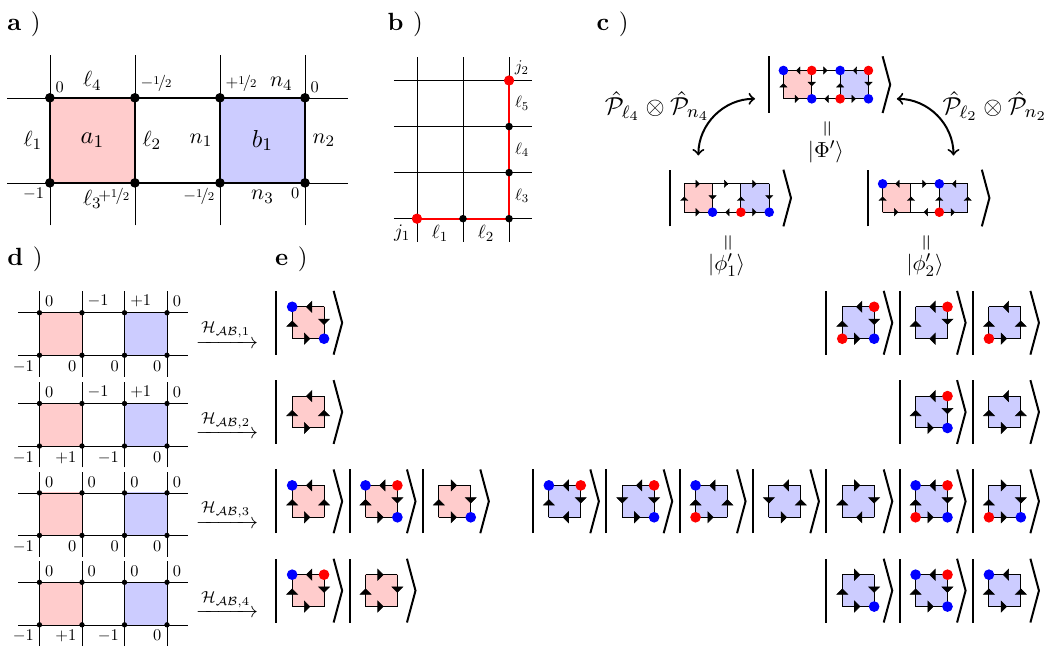
Figure 3. (a) Geometry for L , SS, and sub-regions A and B chosen in the example calculations in presence of dynamical fermions. (b) Example of a path, Γ = [ ‘ 1 , . . . , ‘ 5 ] , connecting two lattice points j 1 and j 2 . Dynamical fermionic matter lives on the lattice sites, while gauge fields live on links between sites. (c) A linear combination of the three states depicted yields an entangled state of a U(1) gauge theory in presence of dynamical fermionic matter. The entanglement can be witnessed by the operator ˆ C 0 defined in equation (4.4). Its constituents are path operators ˆ P ‘ ⊗ ˆ P n and 4 4 ˆ P ˆ P ‘ 2 ⊗ n 2 (see equation (4.2)), which connect the three states as illustrated. (d) Compatible pairs of SSs, H A ( Z A ,n ) ⊗ H B ( Z B ,n ) with n = 1 , . . . , 4 , associated with regions A and B . (e) Choice of basis for the SSs in 3d. States are illustrations of | ϕ j i and span H X ( Z X ,n ) . Negative (positive) X ,n charges can only live on odd (even) sites and whenever they are present ˆ ψ † ˆ ψ takes the value 0 (1), marked by a red (blue)